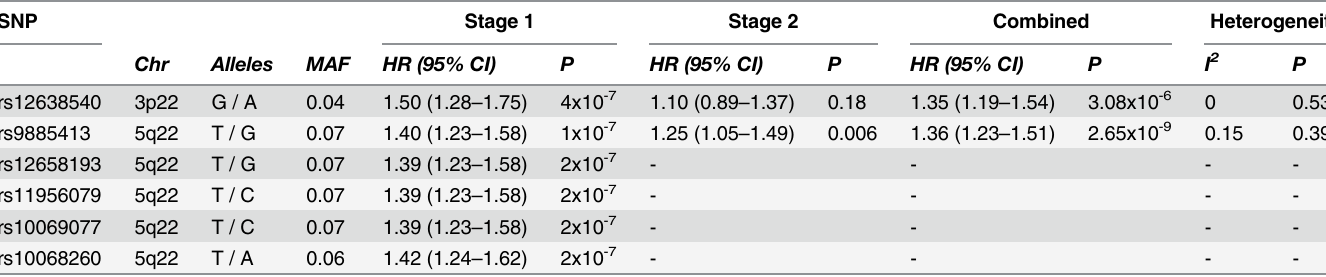
Table 2. Association of genetic polymorphisms with HF mortality.